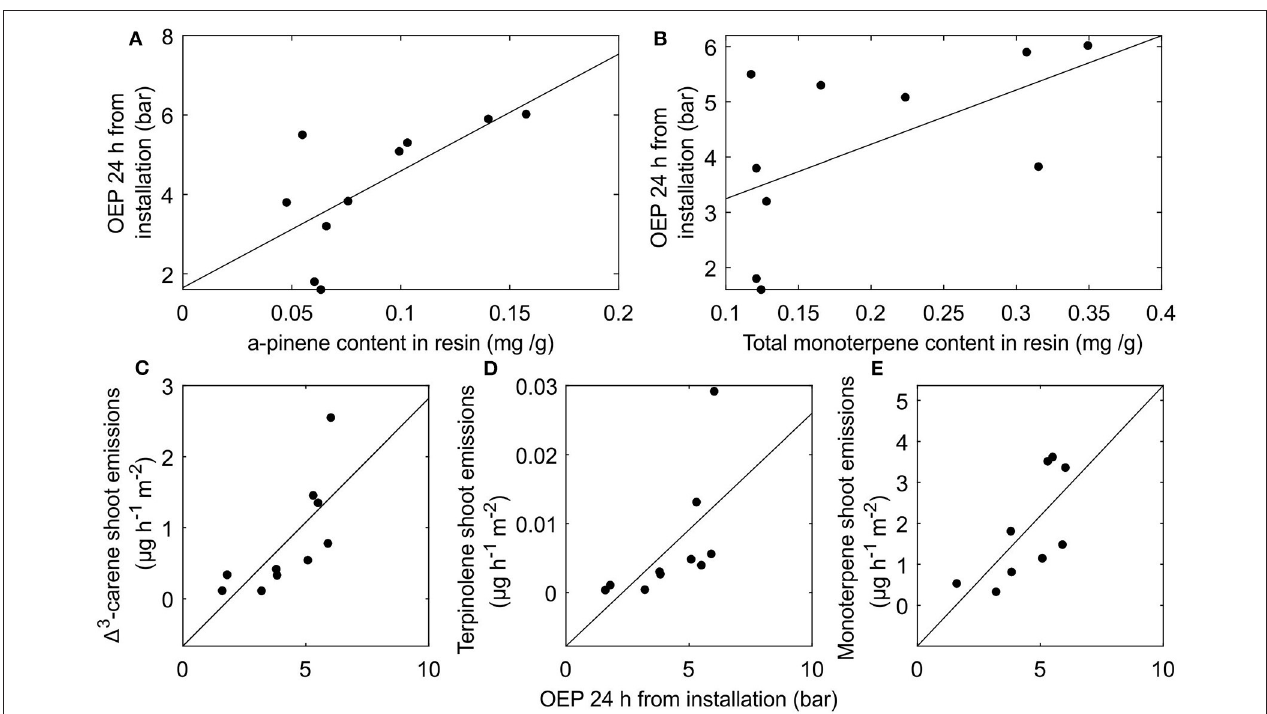
FIGURE 7 | The interrelations between stem resin composition, oleoresin exudation pressure (OEP), and shoot monoterpene emissions Scots pine trees. (A) correlation between α -pinene content in resin and OEP 24h after pressure transducer installation (B) correlation between total monoterpene content in resin and OEP 24h after pressure transducer installation (C) correlation between OEP 24h after pressure transducer installation and 1 3 -carene emissions from shoots (D) correlation between OEP 24h after pressure transducer installation and terpinolene emissions from shoots and (E) correlation between OEP 24h after pressure transducer installation and total monoterpene emissions from shoots with one outlier tree